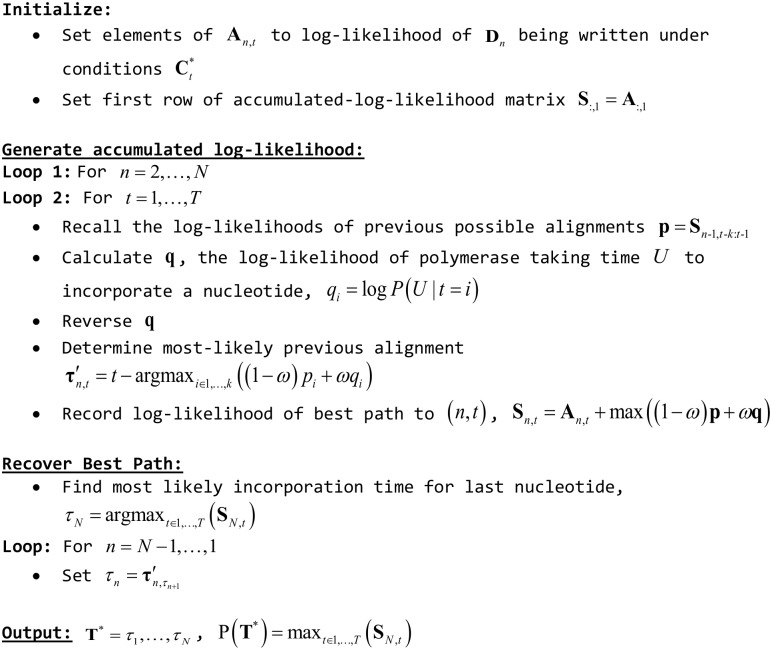
Pseudocode for alignment algorithm.